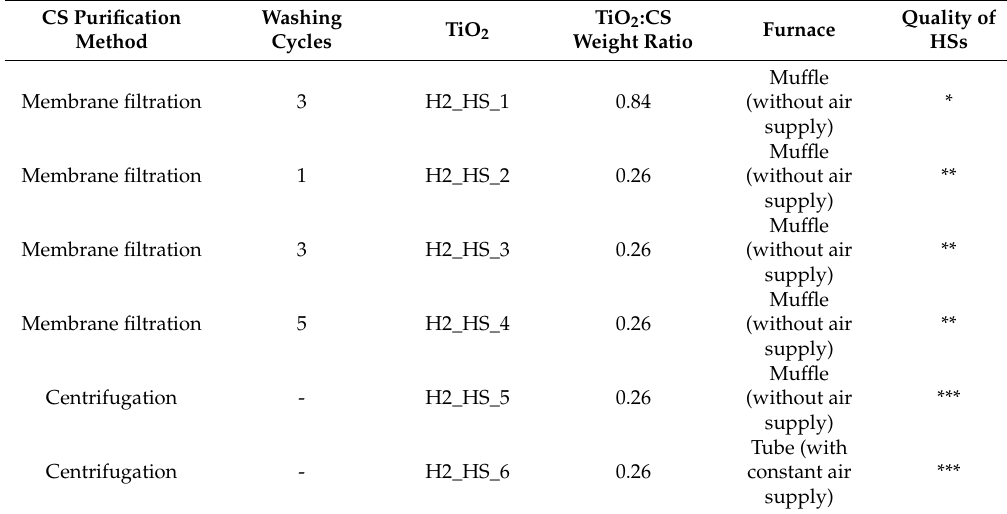
Table 1. Applied synthesis parameters during the preparation of TiO 2 -C composites and HSs (*: no HSs; **: moderate quality HSs; ***: excellent quality